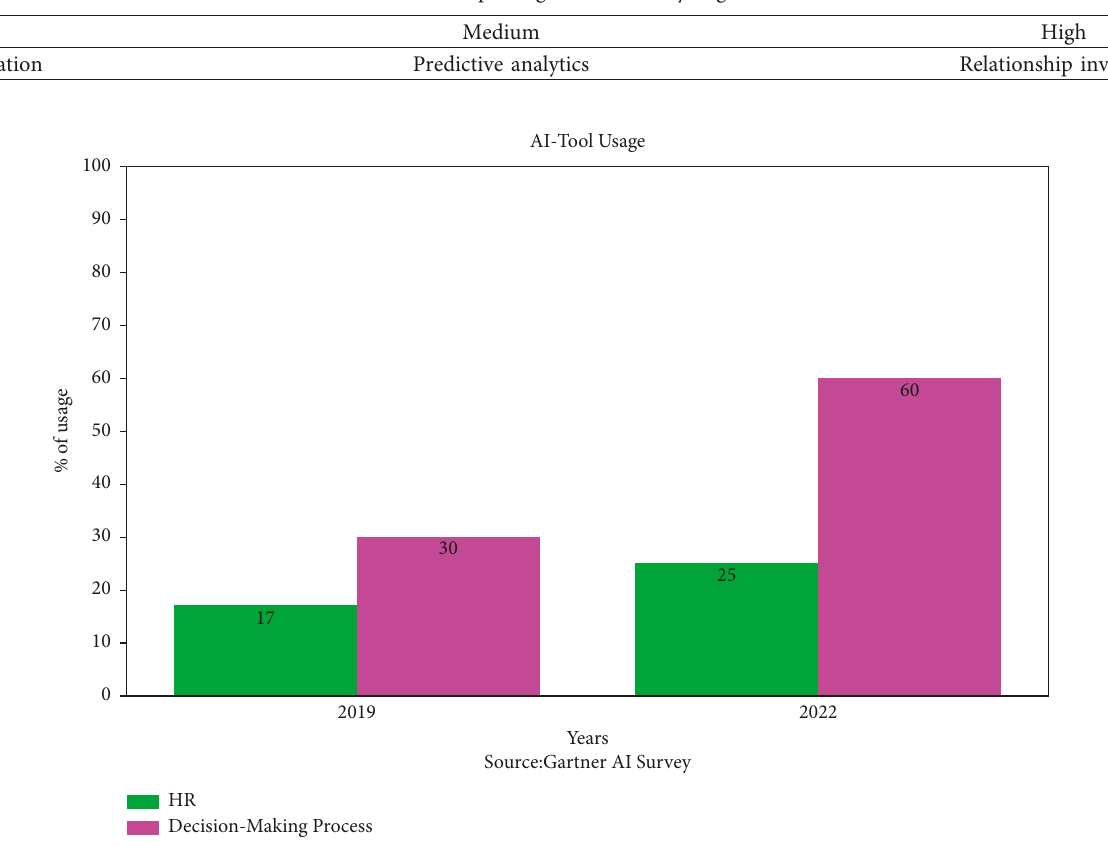
Figure 9: Gartner AI survey of AI tools